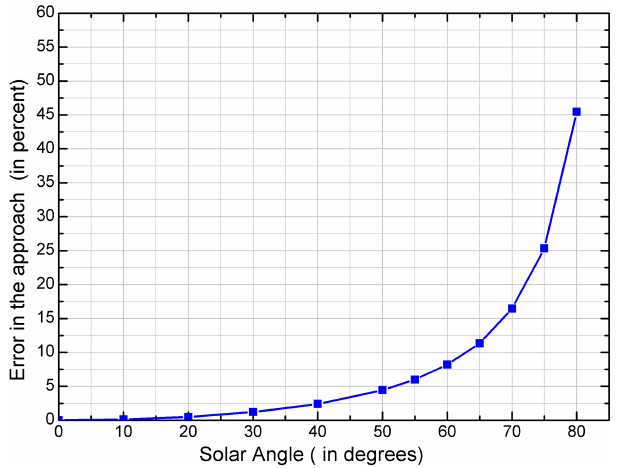
Figure 5. Estimated error of the MGA versus the SZA.